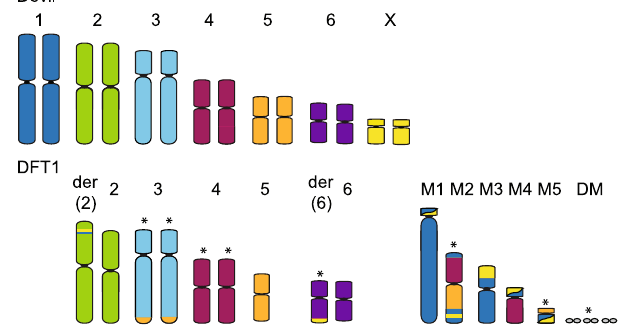
Figure 1. The normal devil karyotype consists of 6 pairs of autosomes and a pair of sex chromosomes. In DFT1, chromosome 1 and X material is spread across up to 5 marker chromosomes (M1-M5) (colour-coded to show their homology to devil chromosomes). Chromosomes varying between and within DFT1 strains are indicated by an asterisk, including the presence or absence of double minutes (DM). The karyotype has been arranged according to the original devil and standard dasyurid karyotypes 46 , differing from the karyotype presented by Pearse and Swift 6 in the order of chromosomes 1 and